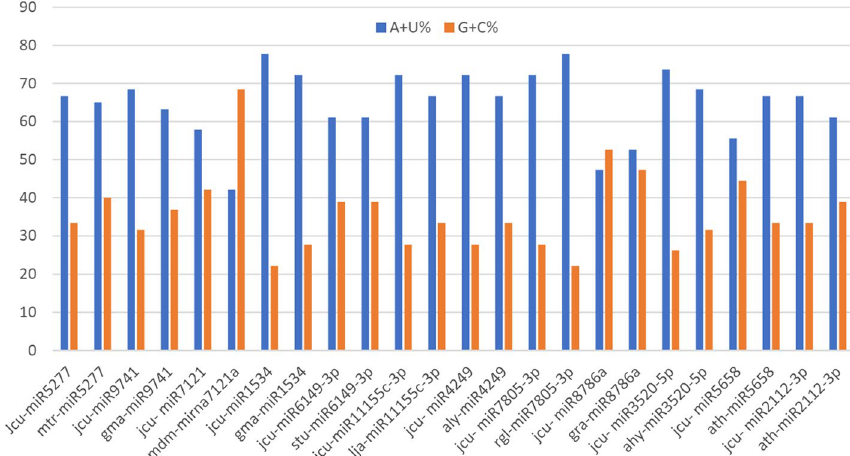
Fig. 4 Overall nucleotide compositions (A